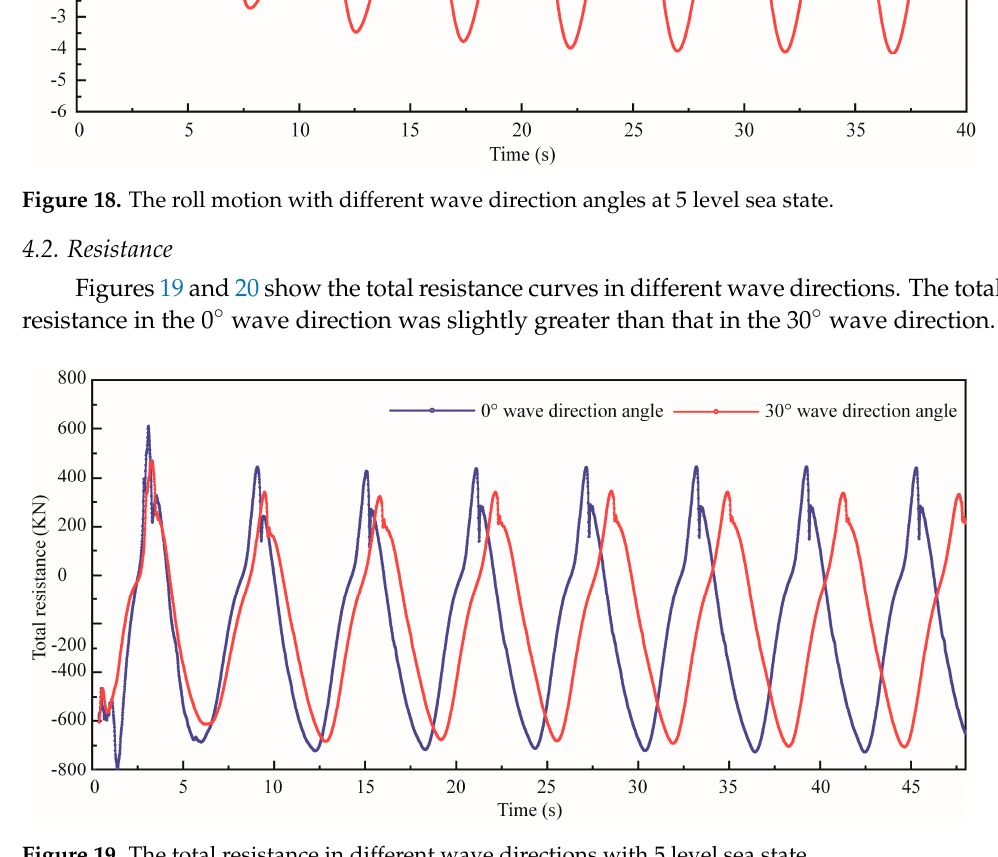
Figure 19. The total resistance in different wave directions with 5 level sea state.